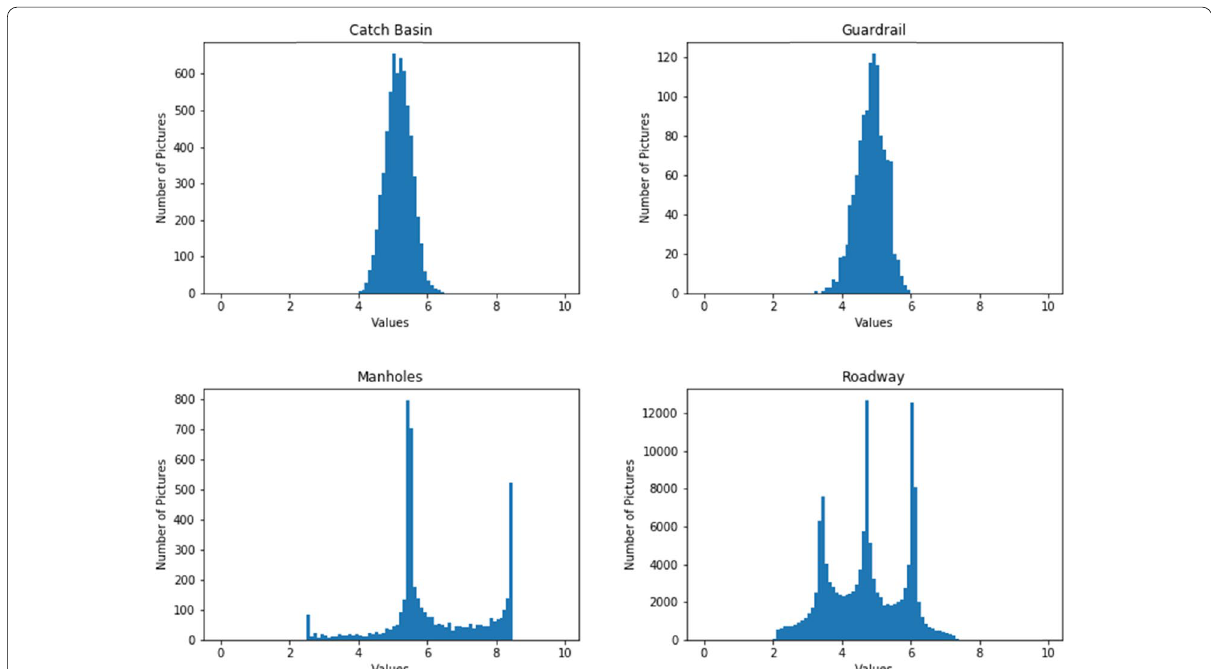
Fig. 24 Model generated condition score of transport infrastructure assets